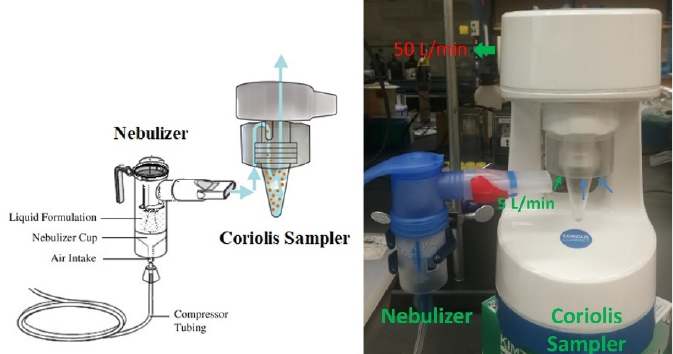
Figure 11. Simulation of SARS-CoV-2 in the air using PRONEB ® nebulizer and virus collection using the Coriolis COMPACT sampler. The cyclone-based sampler has a working flow rate of 50 L/min. During the experiment, 45.0 L/min of air was sucked with the 5.0 L/min of SARS-CoV-2 aerosols by the sampler at a flow rate of 50 L/min in total, leaving the liquid solution in the vial of the sampler.